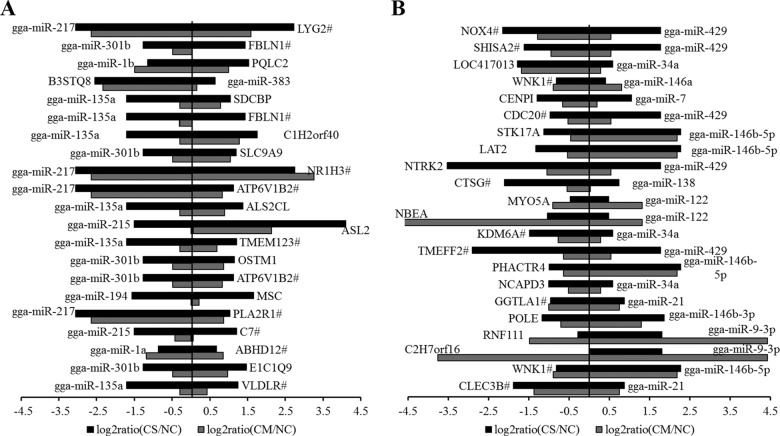
Integrated analysis of differently expressed miRNAs and mRNAs during APEC infection. (A) Negatively correlated expression of downregulated miRNAs and predicted targets. (B) Negatively correlated expression of upregulated miRNAs and predicted targets. The horizontal axis indicates the miRNA and mRNA ratio value of the CM versus NC and the CS versus NC groups, and the vertical axis indicates inverse expression pairs between miRNAs and mRNAs. The expression data were from the same samples of splenic tissues (nonchallenged control, challenged/mild pathology, and challenged/severe pathology groups) determined by Solexa sequencing. RNAhybrid system and TargetScan, version 6.2, were used to predict the miRNA targets. The Pearson correlation coefficient was used to estimate the expression relationships of miRNAs and mRNAs. Only miRNA-mRNA pairs with an r of less than −0.8 were considered to be strongly inversely correlated.